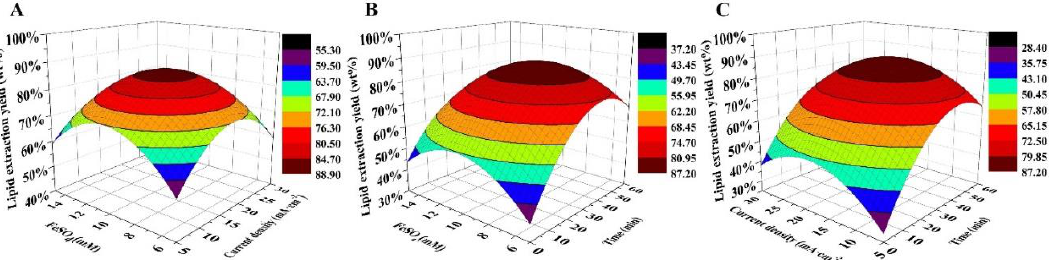
Figure 2. Respond surface curve standing for the interactive effects of FeSO 4 concentration, current density and time on the lipid extraction yield: ( A ) effect of FeSO 4 concentration and current density; ( B ) effect of FeSO 4 and time; ( C ) effect of current density and time.